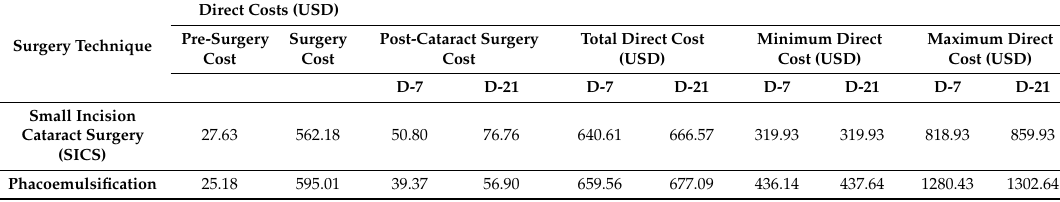
Table 1. Direct Costs of Cataract Surgery Per Capita at Day 7 (D-7) and Day 21 (D-21).